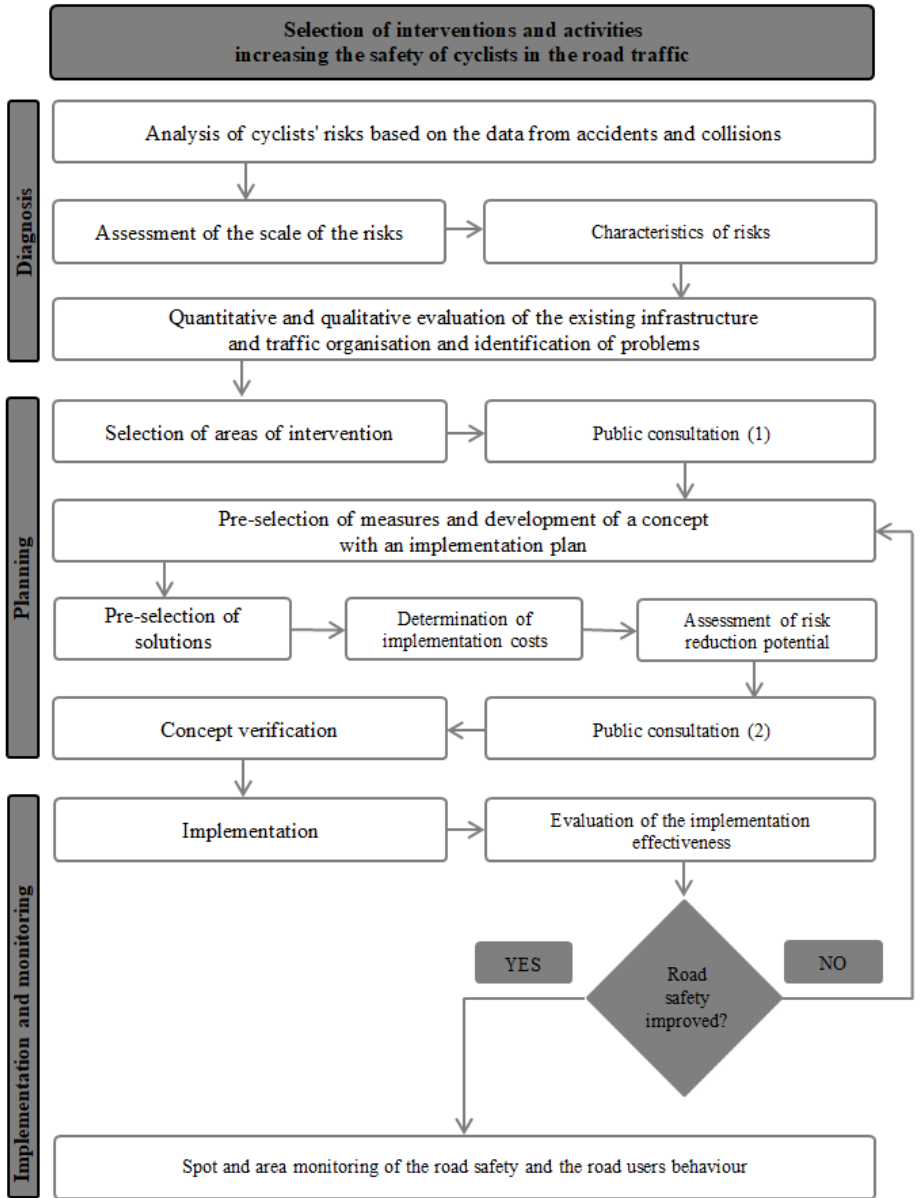
Figure 1. Model of selecting interventions and activities aimed at increasing the safety of cyclists in the road traffic [18].